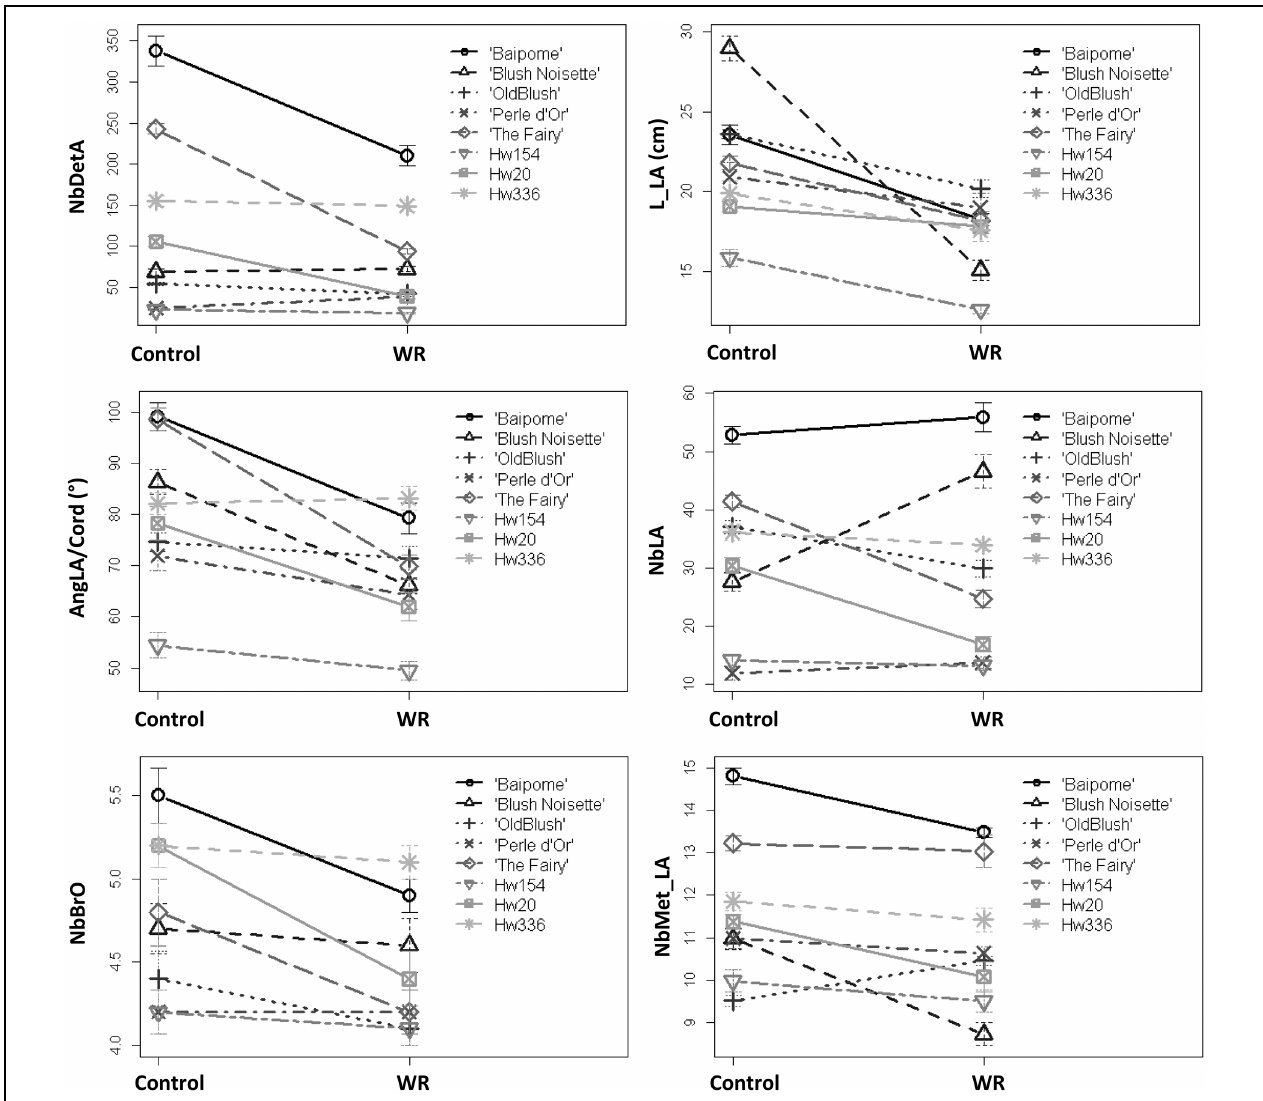
FIGURE 3 | Mean of six architectural variables measured on control plants and plants subjected to a water restriction (WR) treatment of eight rose genotypes. Mean and standard error (SE) of 10 plants per genotype and treatment are shown.